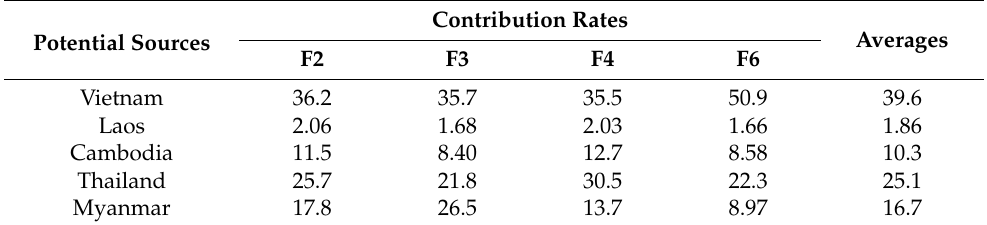
Table 5. The potential contributions of individual countries in mainland Southeast Asia to four receptors, F2, F3, F4, and F6. (unit: